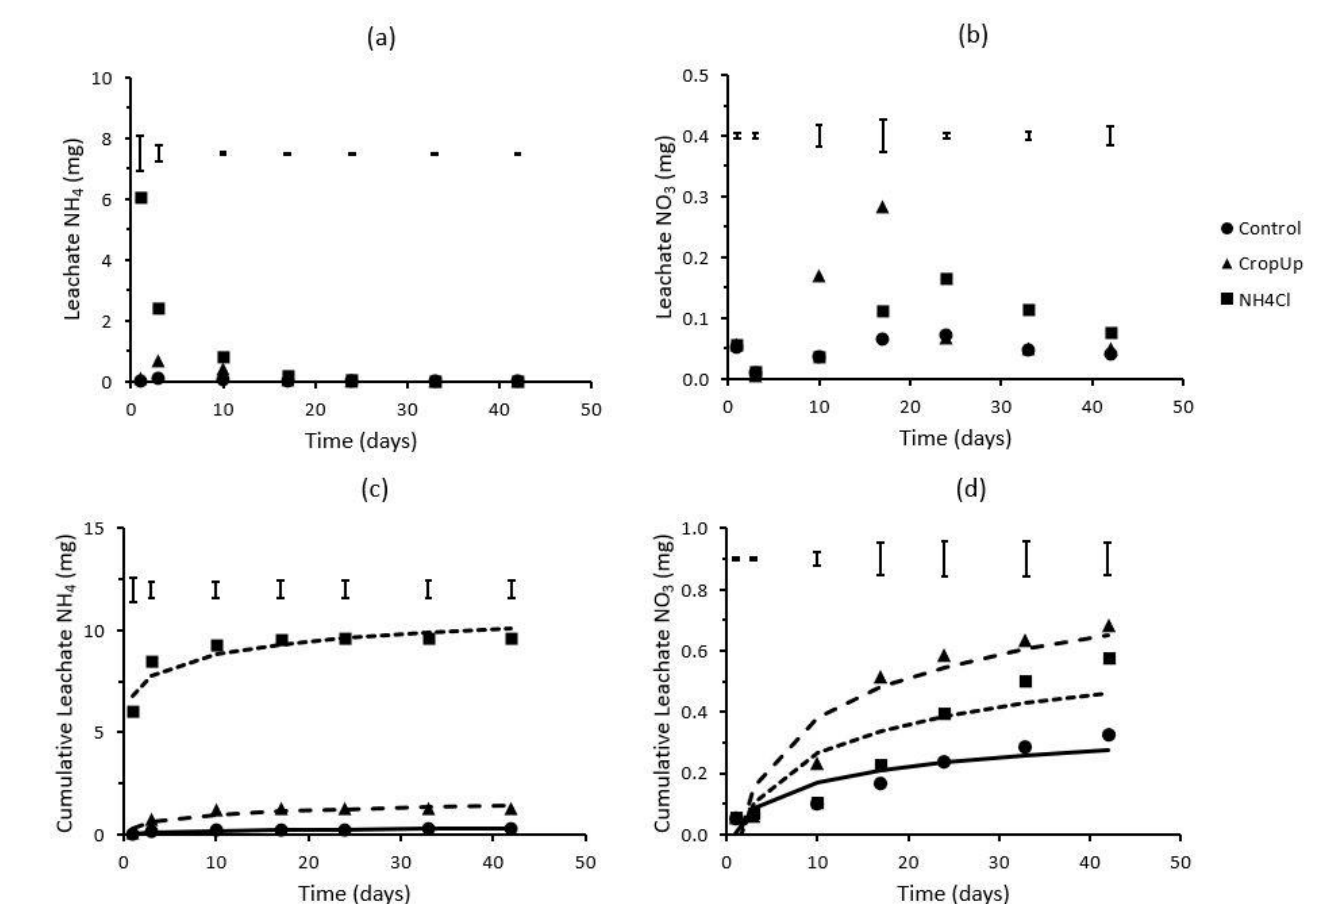
Figure 1. Leachate ( a ) NH 4 and ( b ) NO x , and cumulative leachate ( c ) NH 4 and ( d ) NO x as a function of time. Bars represent LSD values ( p < 0.05). The solid and dashed lines in ( c ) and ( d ) were predicted using Equation (2).